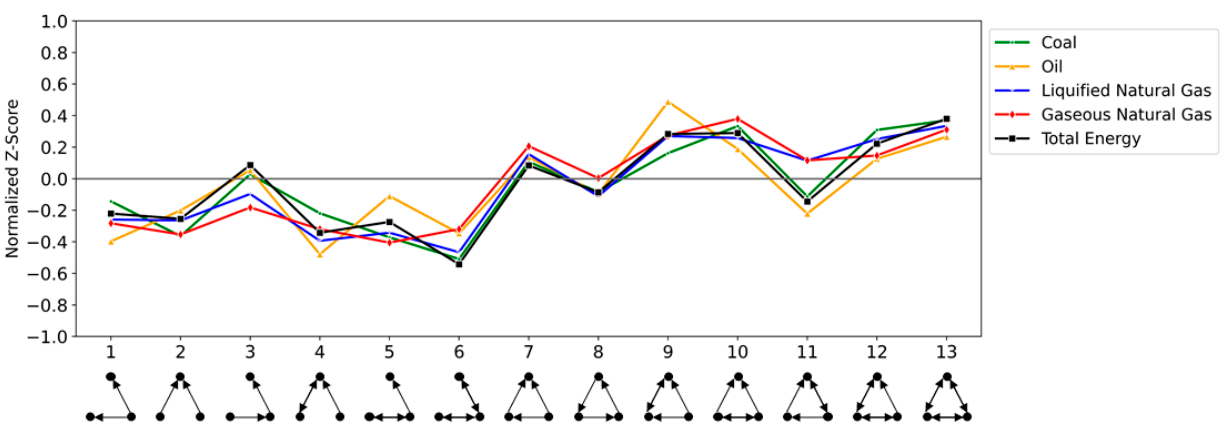
Figure 6. TSPs for individual energy commodity trade networks. Aggregate energy trade is included for comparison. All commodity networks are highly correlated with the aggregate energy network (R > 0.86 in all cases), with coal trade being most similar to aggregate energy trade. See Table 2 for full correlation coefficients.